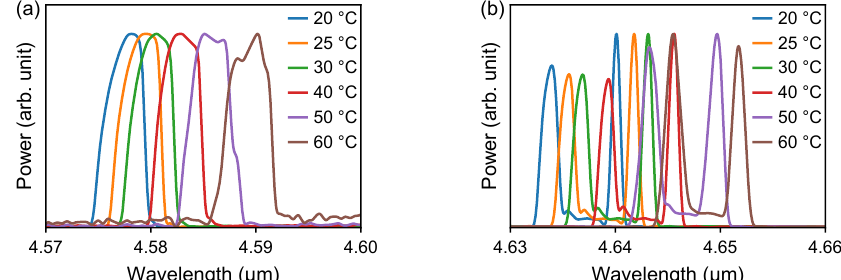
Figure 7. Normalized spectral dependence on the temperature for ( a ) a DFB laser from channel 2 with a 200 ns drive pulse width and ( b ) a DBR laser from channel 5 with a 100 ns drive pulse width. Heating during the pulse limits the linewidth of each